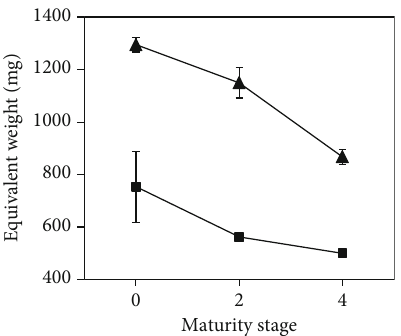
Figure 2: Equivalent weight of pectin extracted from mango peel as function of maturity stage (0, 2, and 4) at 37 kHz ( ▲ ) and 80 kHz ( ■ ) after 20 min.